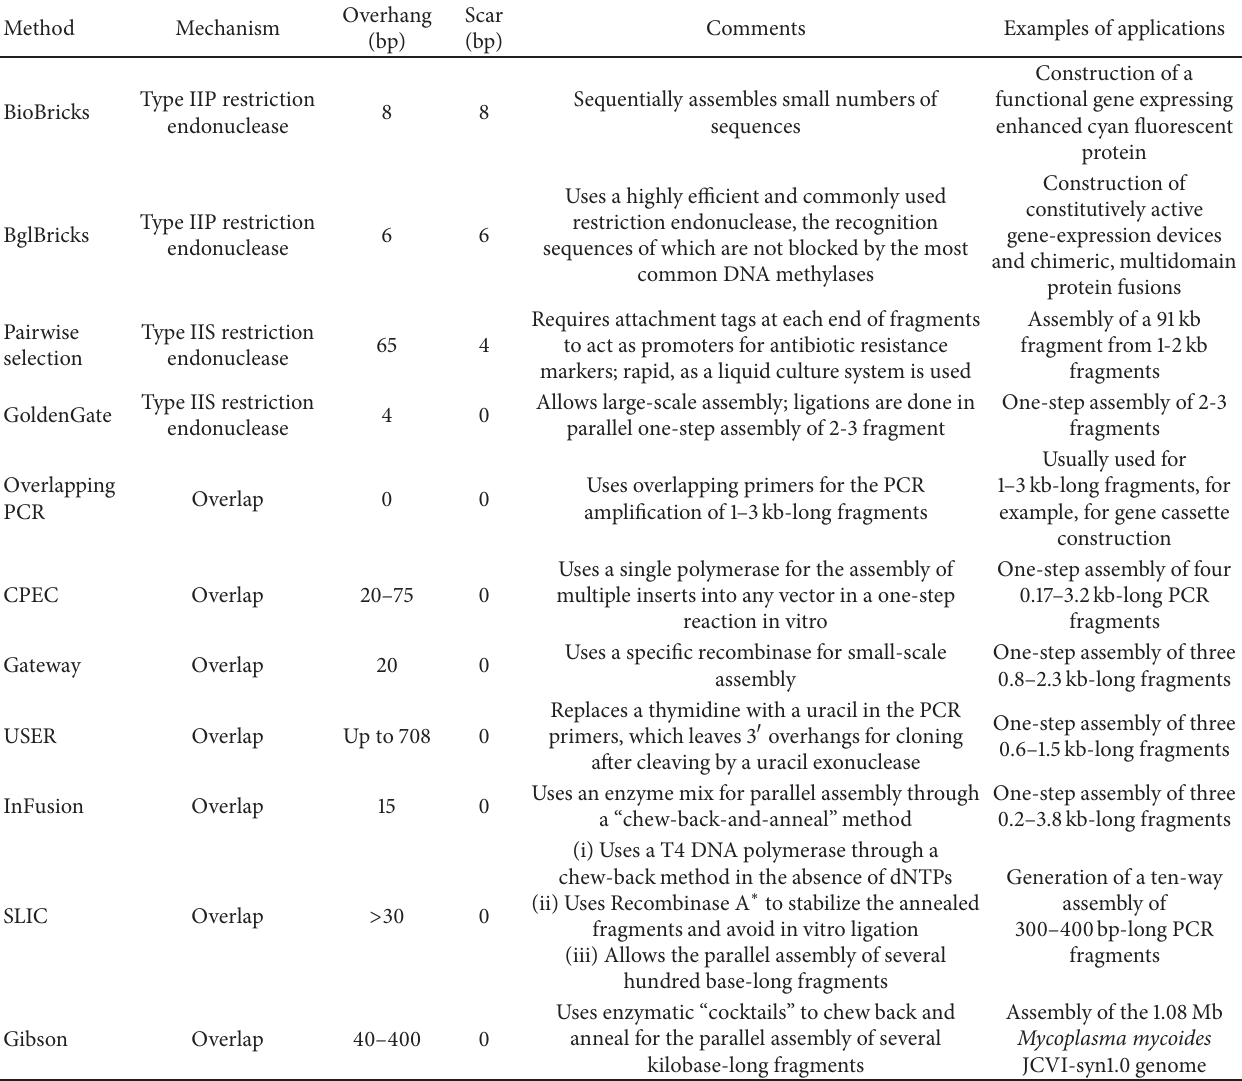
Table 1: Current DNA assembly methods for the synthesis of large DNA molecules. The table has been reproduced from Nature reviews 14: 781–793, with permission from Nature Publishing